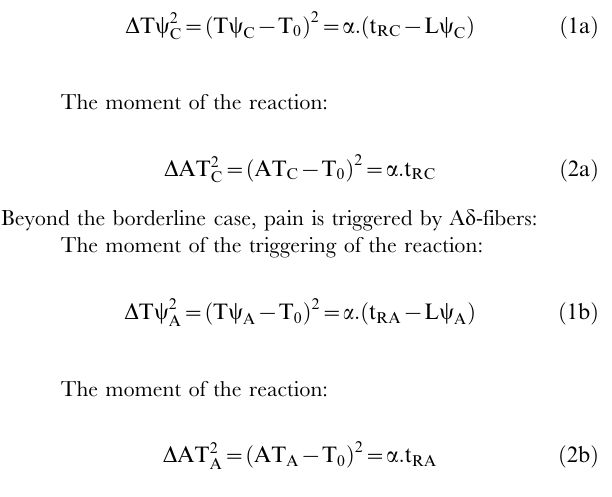
Figure 2. Consequences of the existence of a double afferent system (1). The correctness of the hypothesis that the pain threshold is higher when triggered by A d -fibers than when triggered by C-fibers means that the response is triggered first by C-fibers (red arrows) then by A d -fibers (blue arrows) when one progressively increases the radiant heat power. Let us refer as to R C and R A for these two types of responses. - A For the lower stimulation powers that allow the skin temperature to reach T y C but not T y A. , pain is triggered only by C-fibers following a delay L y C . - B There is then a small power range allowing the skin temperature to reach both T y C and T y A , with R C being triggered before R A . - C The higher stimulation powers allow the skin temperature to reach both T y C and T y A with pain being triggered first by the faster A-fibers following a delay L y A .